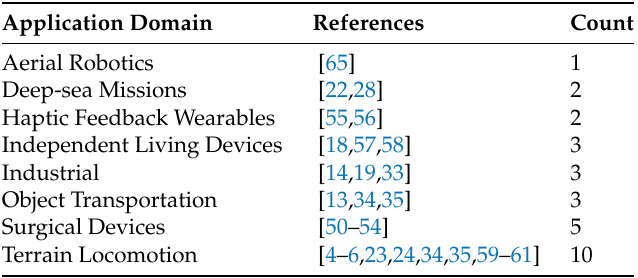
Table 8. Frequency of soft jamming robots per application